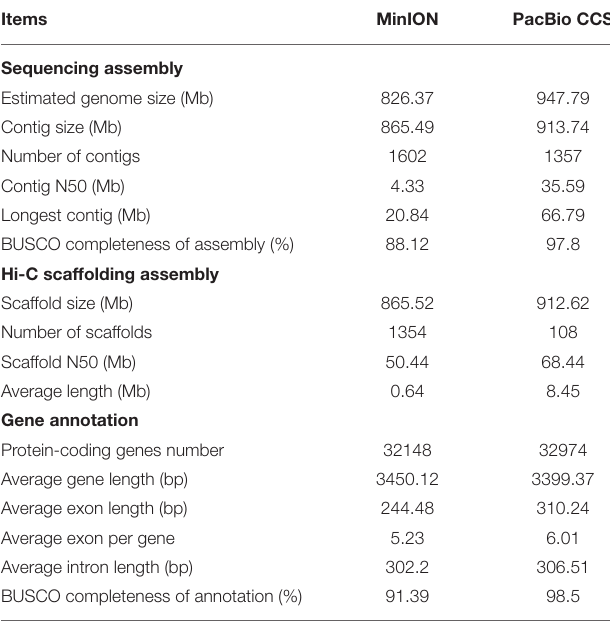
TABLE 1 | Global statistics for assembly and annotation of Strobilanthes cusia